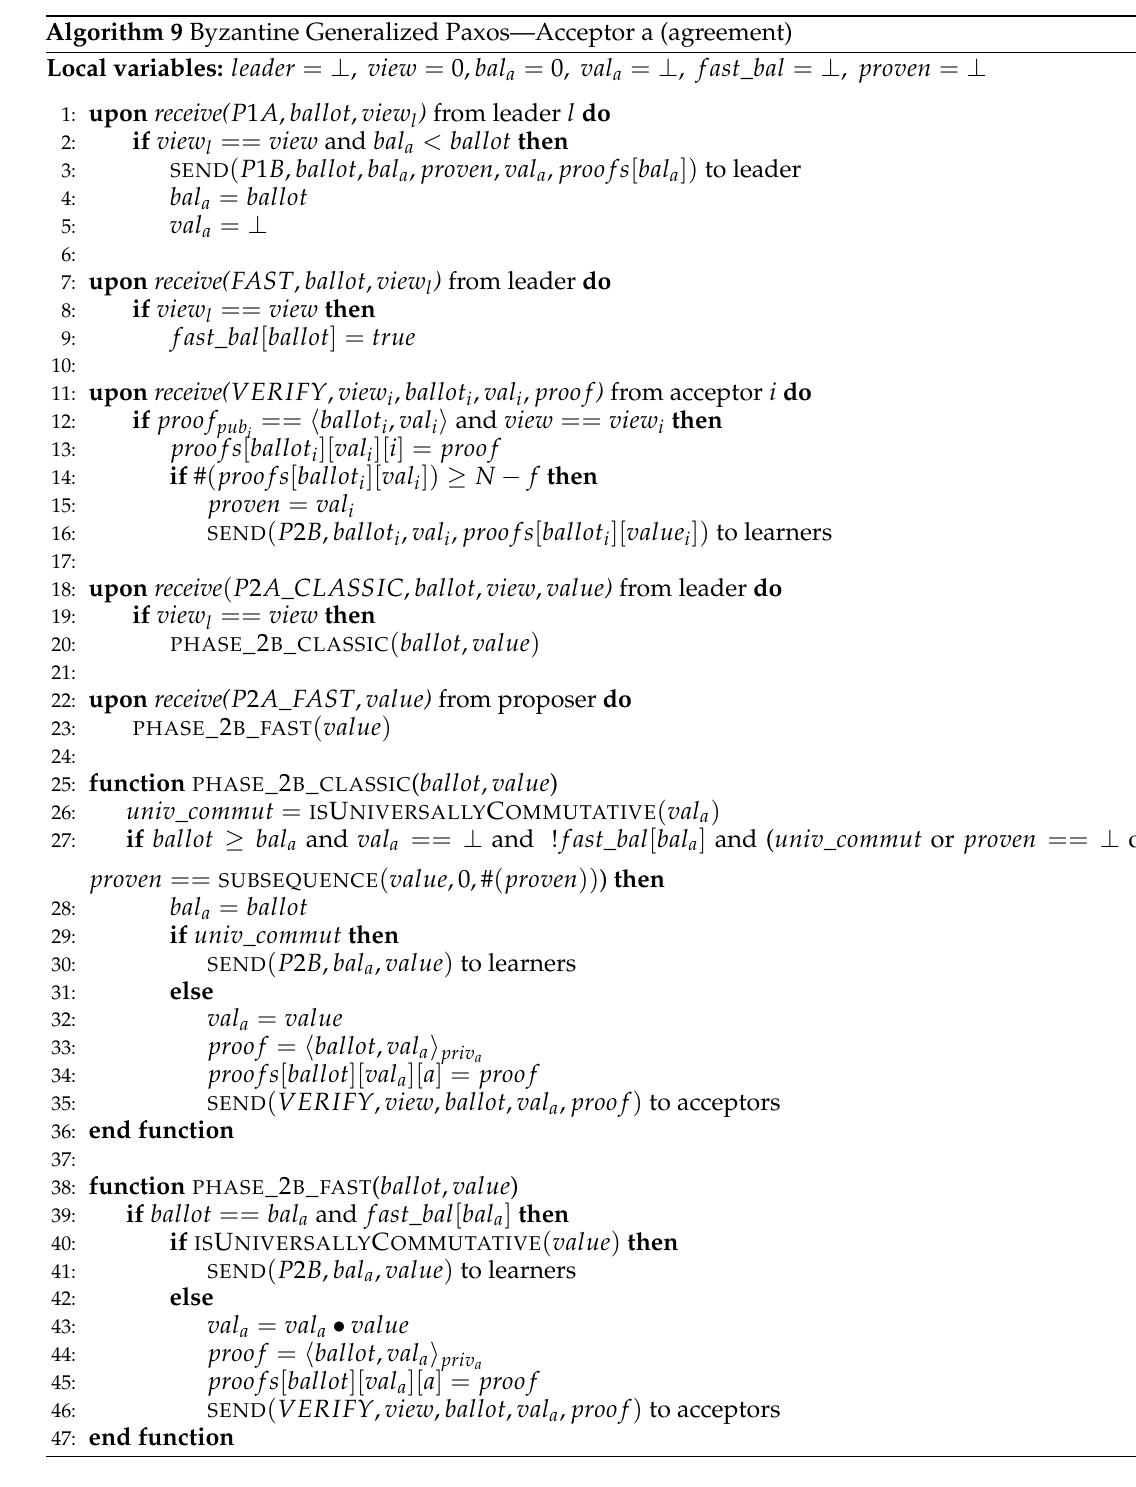
Algorithm 9 Byzantine Generalized Paxos—Acceptor a